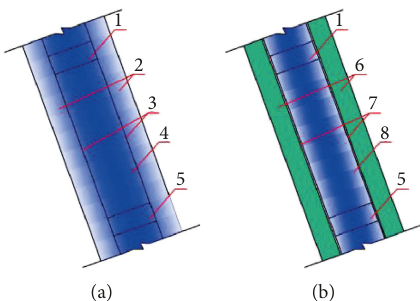
Figure 3: (a) 1 st and (b) 2 nd boundary conditions of the intervening pillar. 1, top pillar; 2, nonrecoverable orebody; 3, ore grade limit; 4, recoverable orebody (intervening pillar); 5, bottom pillar; 6, sur- rounding rock; 7, ore-rock boundary; 8, orebody (intervening